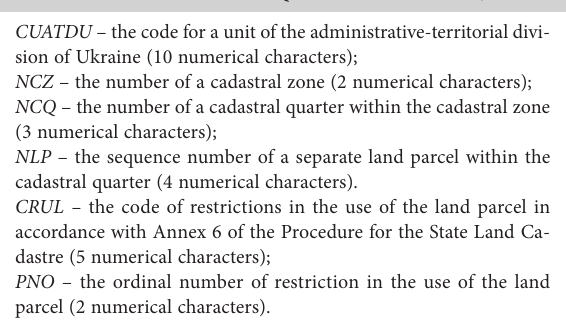
Figure 6. The proposed structure of the cadastral number of restrictions in the use of the land